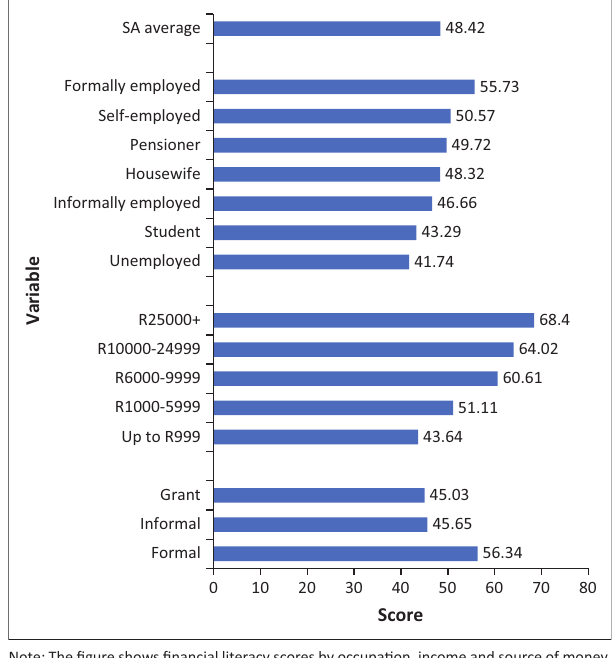
TABLE 3: Provincial ranking of financial literacy in South Africa.